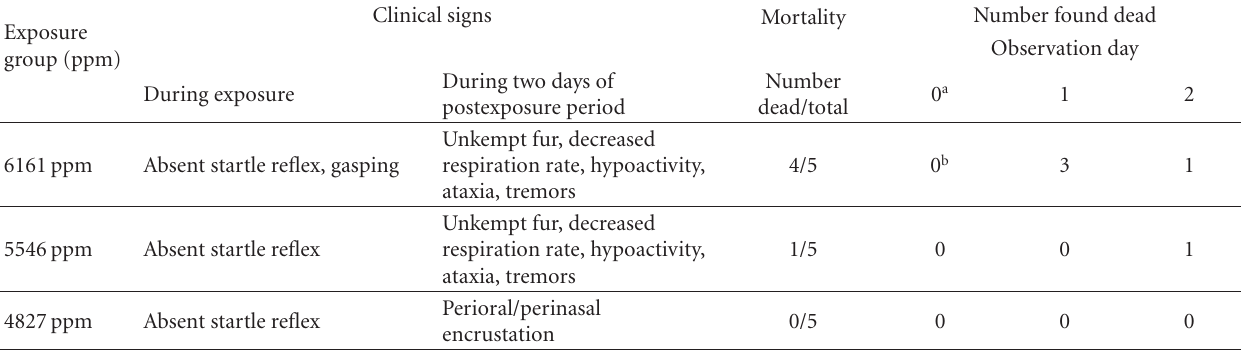
Table 3: Clinical observations, mortality rates, and day of death for male rats following 1-hour exposure to EO. Exposure